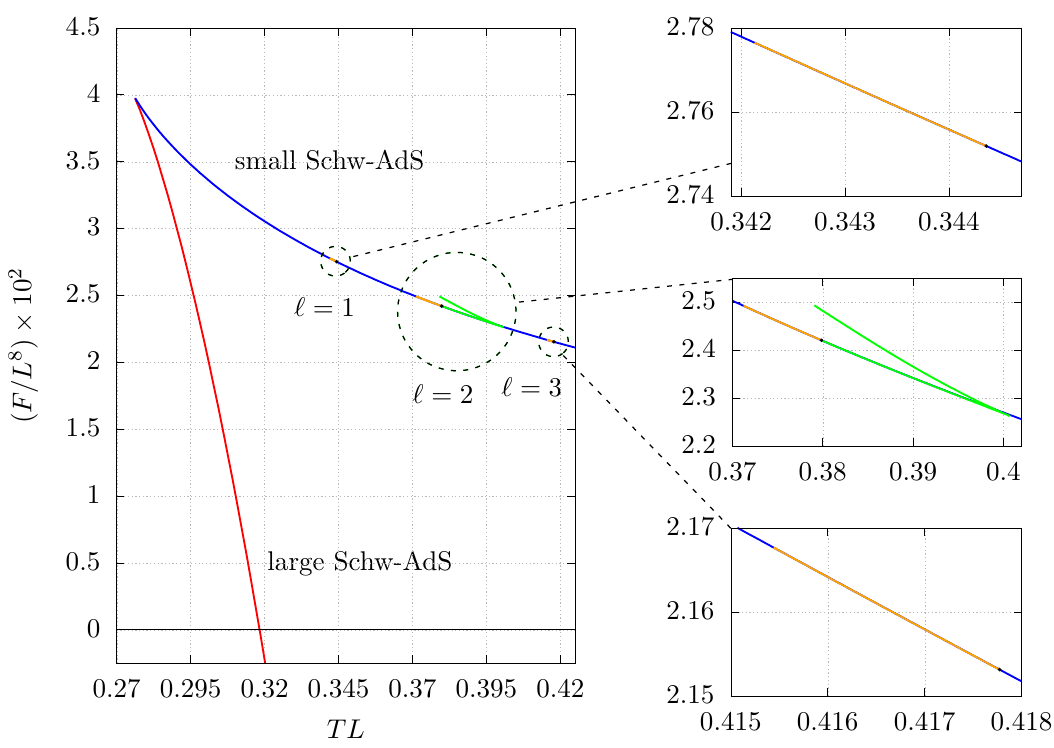
Figure 7. Phase diagram in the canonical ensemble of all lumpy black holes we have found in D = 11 . The GL threshold points for the various modes are indicated with black solid disks. The zero of the free energy is taken to be the background AdS black holes are subdominant with respect to thermal AdS they